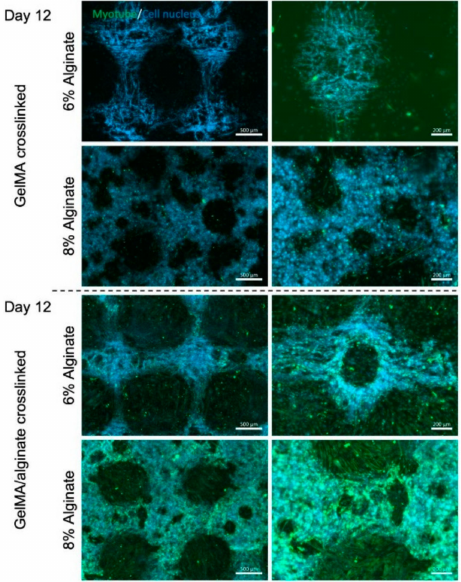
Figure 6. Anti-Desmin staining of C2C12 myotubes in GelMA hydrogel with alginate concentrations 6% and 8% (w / v) crosslinked with either UV light or UV / CaCl 2 crosslinking. Images were taken on day 12 after bioprinting. Staining was performed to quantify myotube formation, which is marked in green. Imaging shows increased myotube formation upon alginate crosslinking with CaCl 2